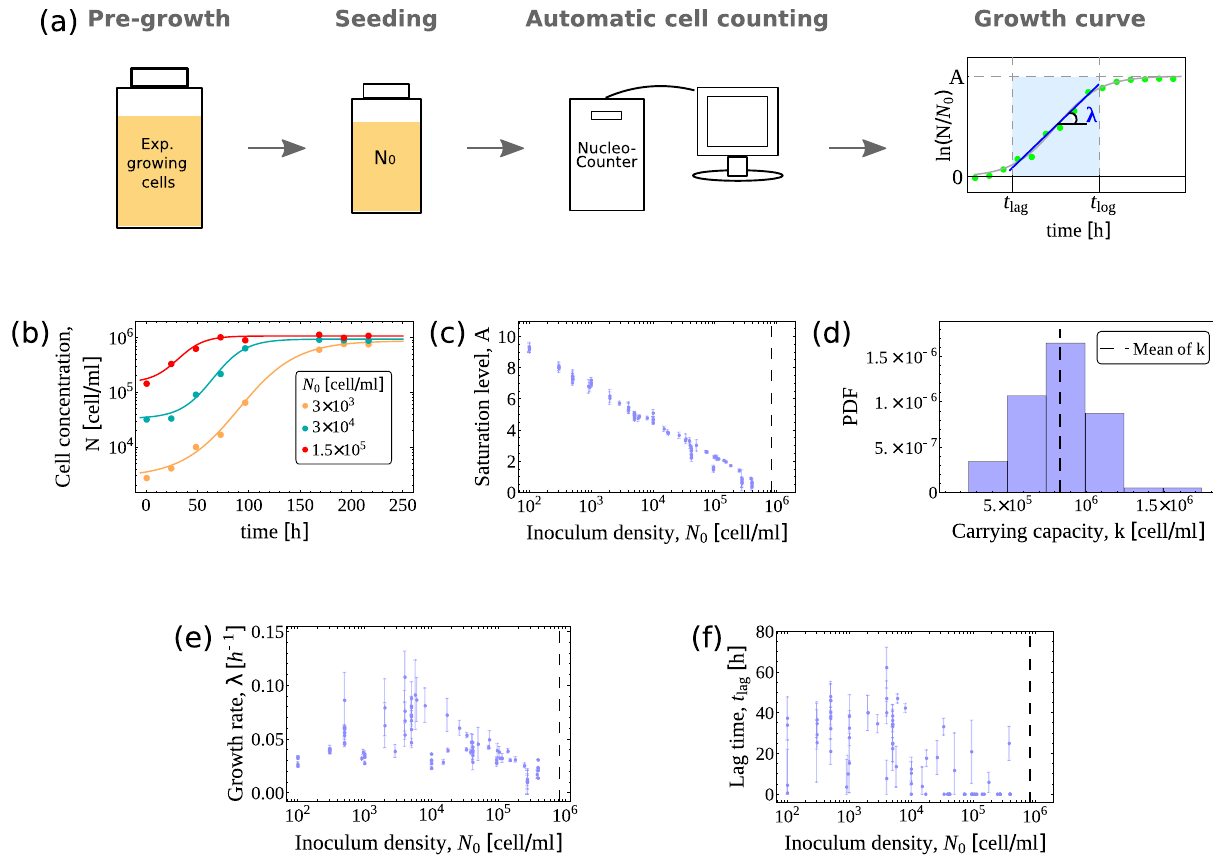
Figure 4. ( a ) Sketch of the experimental procedure employed for K562 cells. The panel on the right shows a representative growth curve (green circles) with the corresponding fit (gray sigmoidal curve). The fitted parameters (growth saturation A , growth rate (cid:31) and lag time t lag ) are emphasized explicitly. ( b ) Three representative growth curves with different inoculum sizes N 0 with their corresponding fits. Data error bars √ N , where N is the concentration of cells. Their size is smaller than the dots, thus they are not are given by visible. ( c ) The growth saturation A , related to the carrying capacity k through the relation A ≡ ln ( k / N 0 ) , is plotted against the inoculum size N 0 . The mean value of the carrying capacity k is shown by the vertical dashed line. ( d ) Empirical distribution of the carrying capacity k . The dashed vertical line represents the mean of the distribution. ( e ) Growth rate (cid:31) as a function of the inoculum size N 0 . Each light blue dot is an estimated (cid:31) with its standard error. The dashed black line corresponds to the mean carrying capacity. ( f ) Adaptation time t lag as a function of the inoculum size N 0 . Light blue dots represent the estimated lag times together with their standard errors. The dashed black line corresponds to the mean carrying